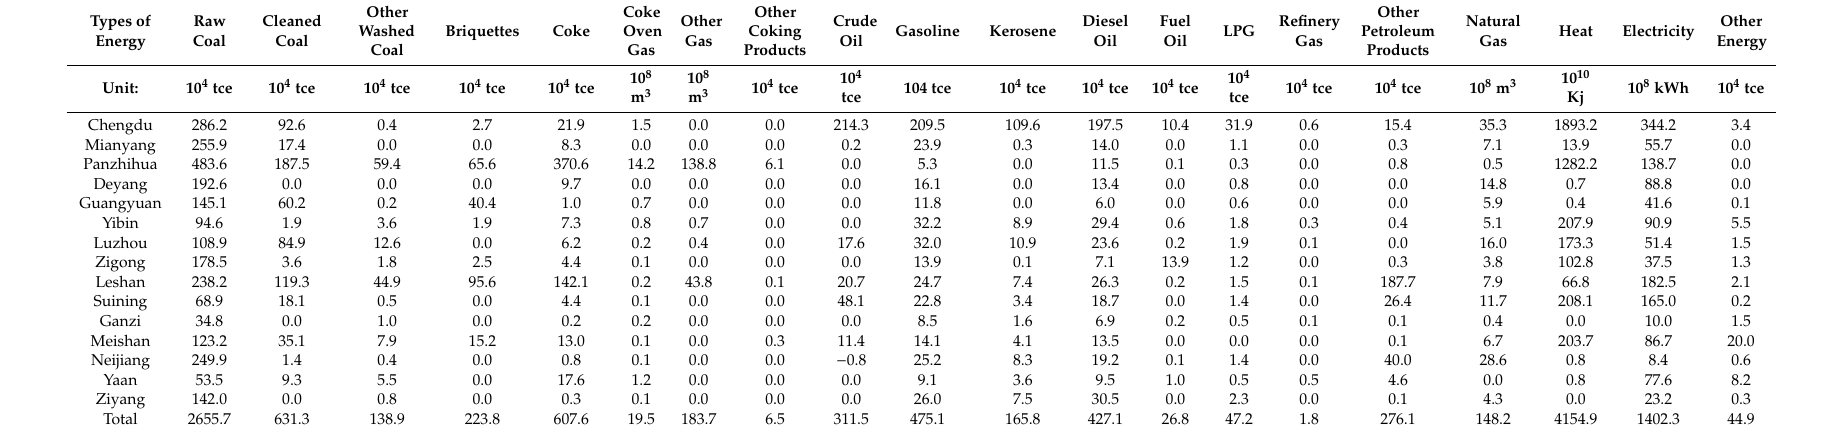
Table 3. Types of energy consume in 15 key cities in Sichuan Province,